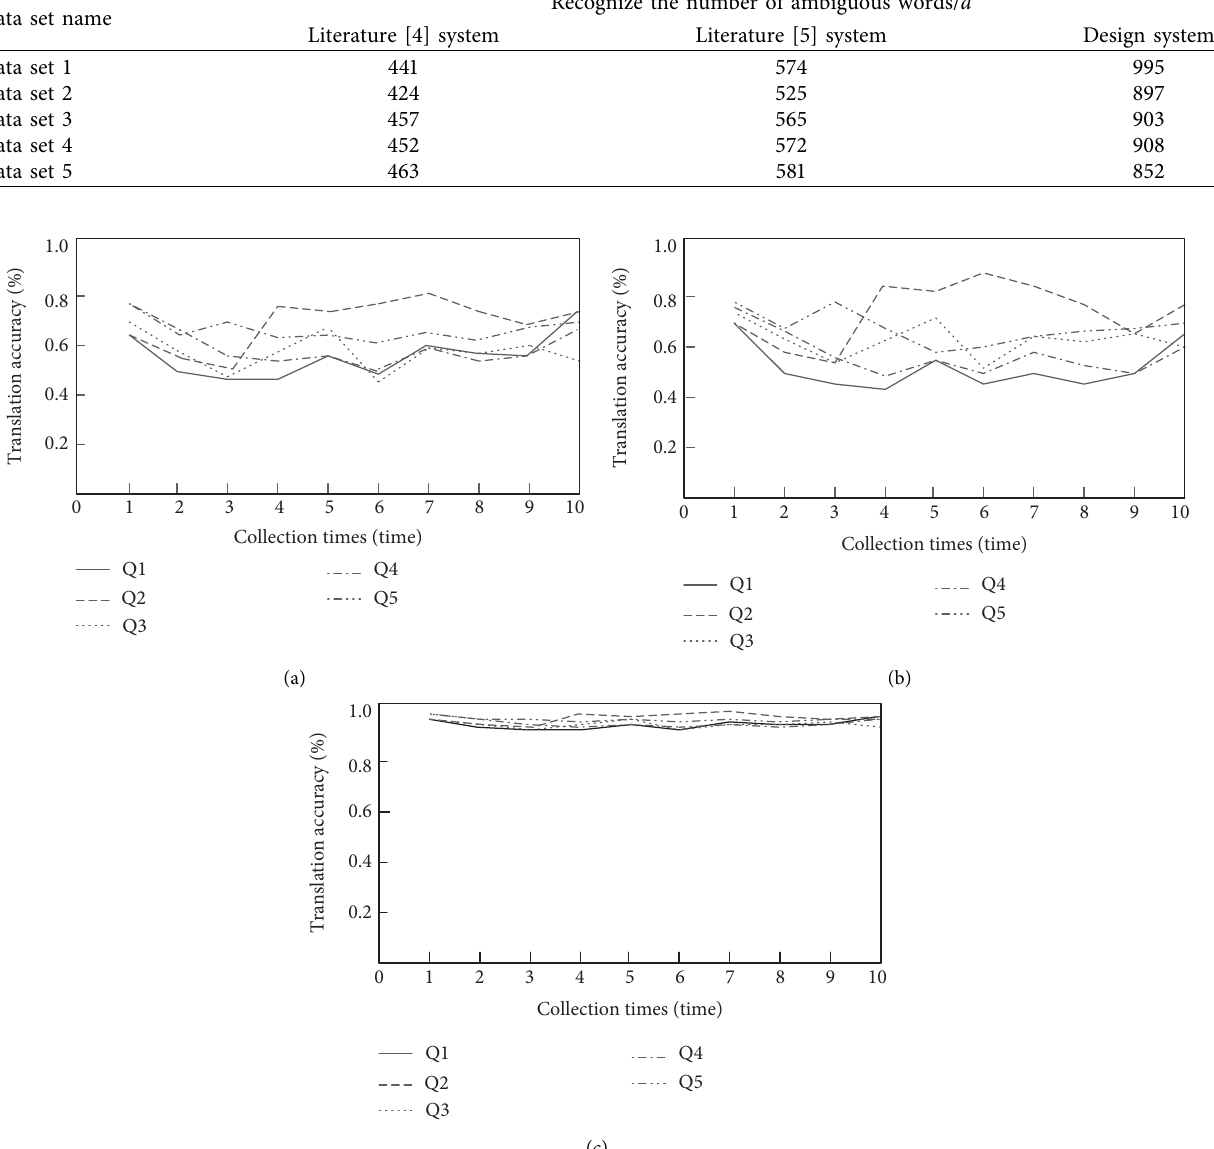
Figure 7: Topology of the test environment. Table 1: The number of ambiguous words identified by three Chinese-English wireless simultaneous interpretation systems.